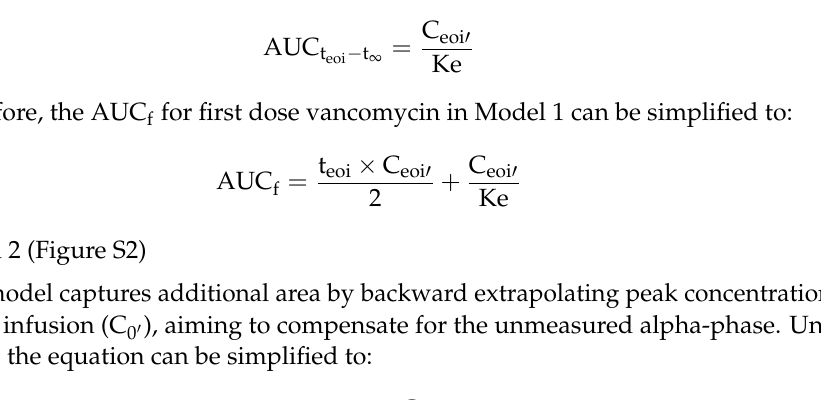
Model 2; Table S4: Agreement, bias, and correlation results from the pediatric data set using Model 1; Table S5: Agreement, bias, and correlation results from the pediatric data set using Model 2; Figure S1: Expected area under the concentration curve calculated using Model 1 compared to the expected first dose vancomycin concentration time profile; Figure S2: Expected area under the concentration curve calculated using Model 2 compared to the expected first dose vancomycin concentration time